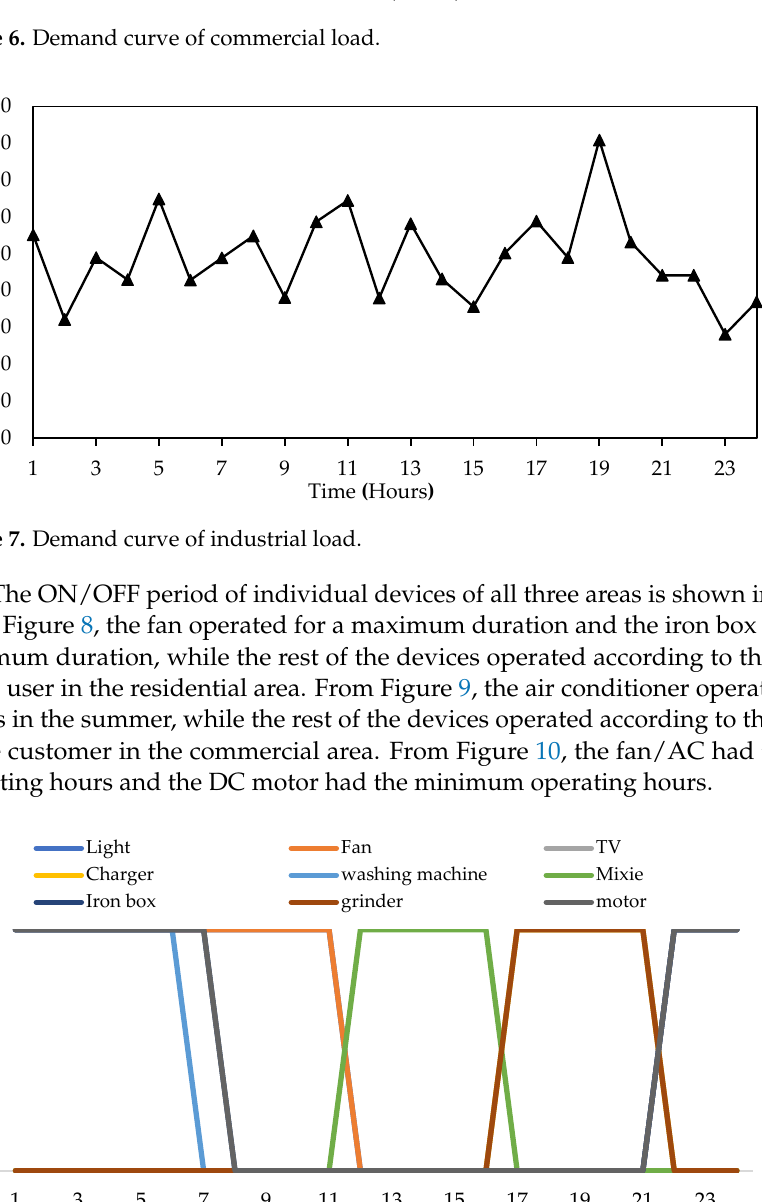
Figure 9. ON/OFF period of individual devices for commercial area. Figure 10. ON/OFF period of individual devices for industrial area. The different load curves of the forecasted objective and load that shifted after DSM with peak load reduction are shown in Figures 11–13. In the residential area, the peak load